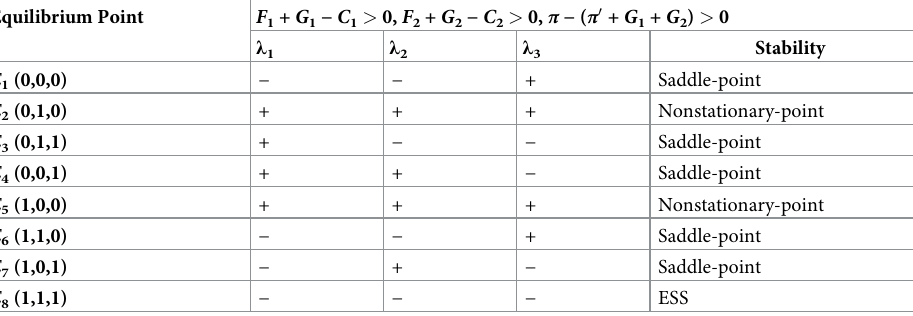
Table 4. Local stability analysis of equilibrium points (Proposition